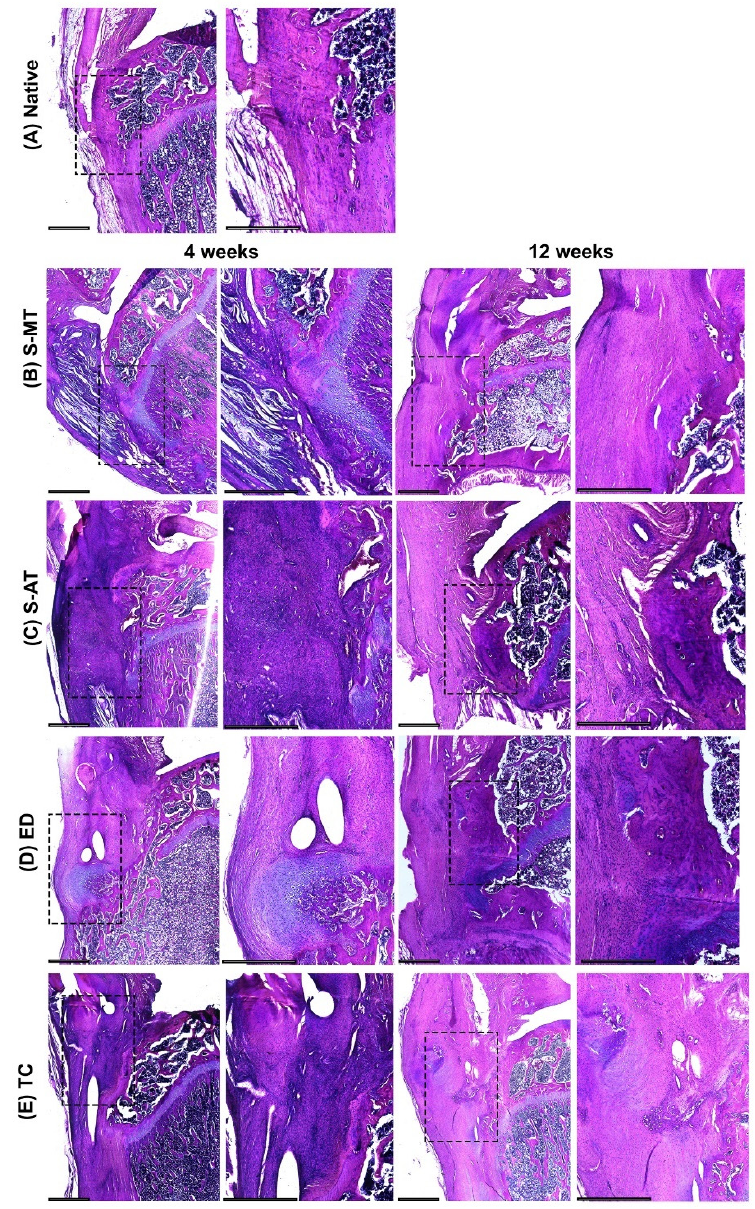
Figure 4. H&E staining. Representative images of the histological analysis of enthesis defects at the patellar region at 4 (left pairs) and 12 weeks (right pairs) after surgery, in ( A ) native enthesis, ( B ) S-MT with mixed transition, ( C ) S-AT with abrupt transition, ( D ) empty defect, and ( E ) transversal cut at enthesis site. Extracellular collagens and muscle fibers appear stained with different shades of pink. Dashed squares in the left pairs indicate the locations of the zoomed-in areas shown on the respective right. Scale bars = 800 µm.